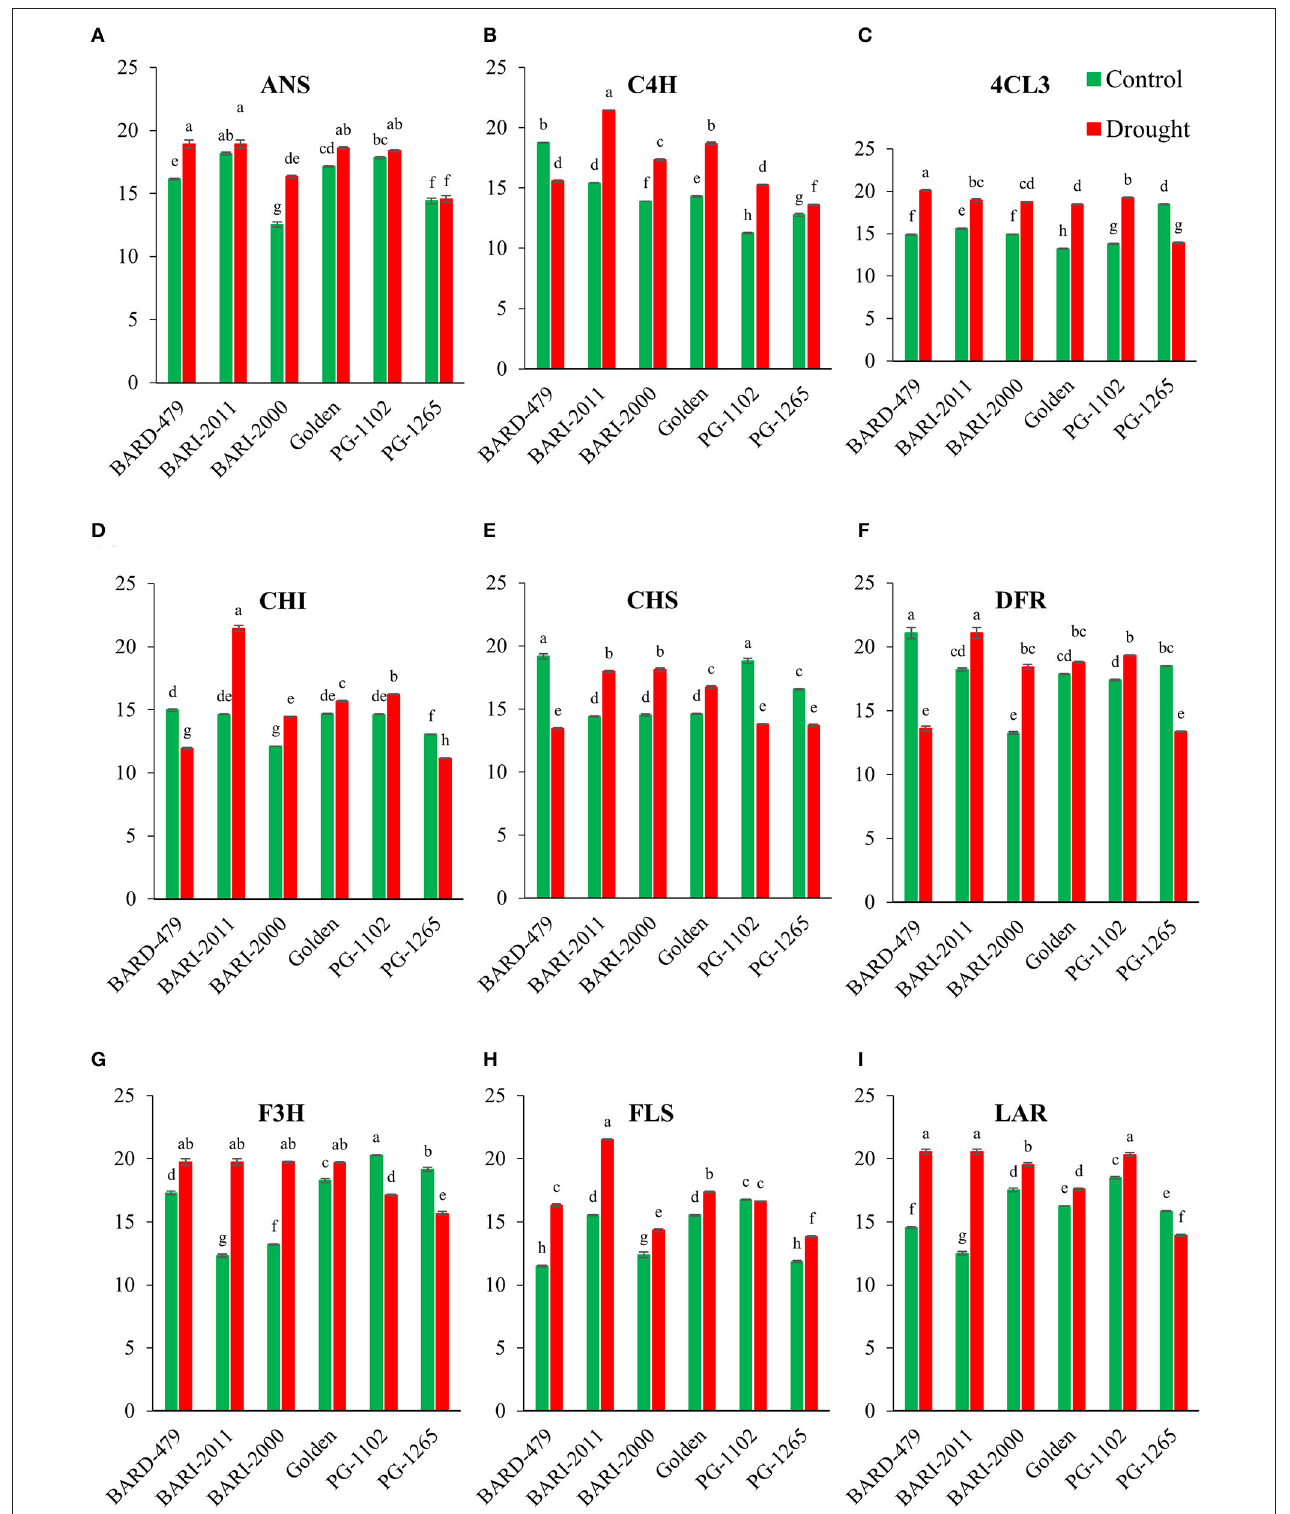
FIGURE 3 | Gene expression profile in leaves of genotypes of peanuts under drought stress. The panel shows the following: the ANS (A) , the C4H (B) , the 4CL3 (C) , the CHI (D) , the CHS (E) , the DFR (F) , the F3H (G) , the FLS (H) , and the LAR (I) . Data are shown as the interaction between the genotypes of peanuts and the drought applied. Significance was inferred either with an ANOVA under the Tukey’s HSD post-hoc test for normally distributed data (Honest Significant Detection, p < 0.05). Non-parametric data were analyzed with a Kruskal–Wallis test under False Discovery Rate post-hoc correction (FDR, p < 0.05).